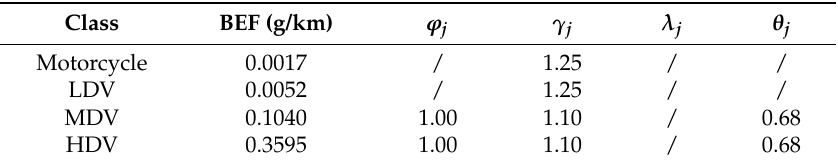
Table 2. Five correction factors of the exhaust emission